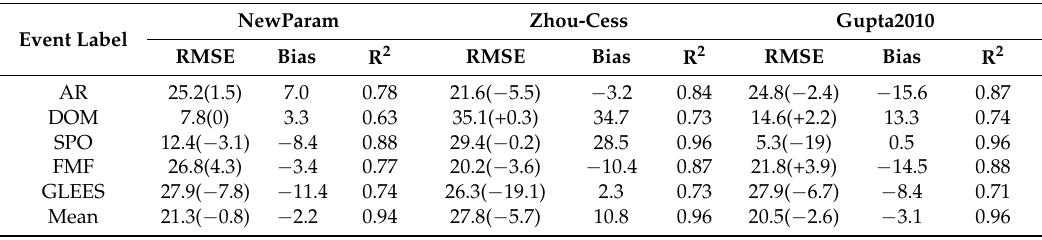
Table 8. Same as Table 7 but for the results in the high-altitude regions. The clear-sky DLRs were estimated using NCEP atmospheric data. The differences between RMSE from NCEP and that from MODIS are displayed in the